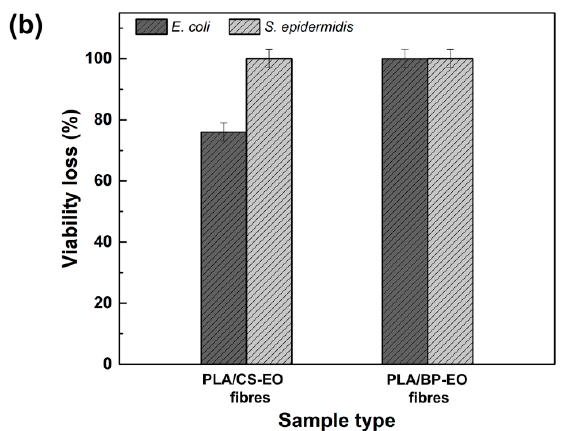
Figure 5. ( a ) Photographs of agar plates showing the growth of E. coli (upper row) and S. epidermidis (lower row) after 24 h of incubation with PLA, PLA/CS-EO (10% v / v CS-EO) and PLA/BP-EO electrospun fibres (10% v / v BP-EO). Scale bar = 1 cm; ( b ) Viability loss of E. coli and S. epidermidis incubated with PLA/CS-EO and PLA/BP-EO fibres.